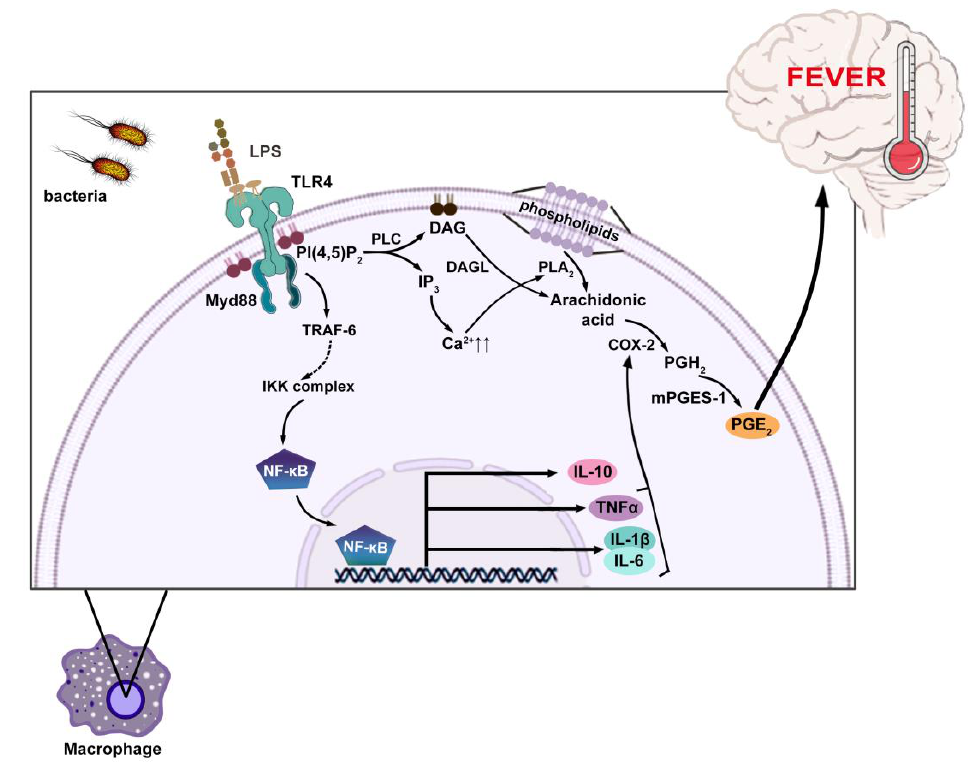
Figure 1. The mechanism of fever. Lipopolysaccharide (LPS) released from bacteria is recognized by Toll-like receptor 4 (TLR4). It provides signal transmission through TRAF6 and IKK family kinases to induce NF- κ B-dependent gene expression, resulting in the release of pyrogenic tumor necrosis factor α (TNF α ), interleukin (IL)1- β and IL-6. TLR4 activation also triggers the hydrolysis of phosphatidylinositol 4,5-bisphosphate (PI(4,5)P2) to diacylglycerol (DAG) and inositol trisphosphate (IP3) by phospholipase C (PLC). Diacylglycerol lipase (DAGL) hydrolyses diacylglycerol (DAG) presented in membrane releasing free arachidonic acid (AA). Additionally, IP3 stimulates calcium liberation from the endoplasmic reticulum to the cytoplasm, which, in turn, drives the activation of phospholipase A2 (PLA2) to release arachidonic acid from membrane phospholipids. AA is then metabolized by cyclooxygenase (COX-2) to prostaglandin H2 (PGH2). Subsequently, microsomal prostaglandin E2 synthase (mPGES-1) converts PGH2 to prostaglandin E2 (PGE2), a major mediator of fever.